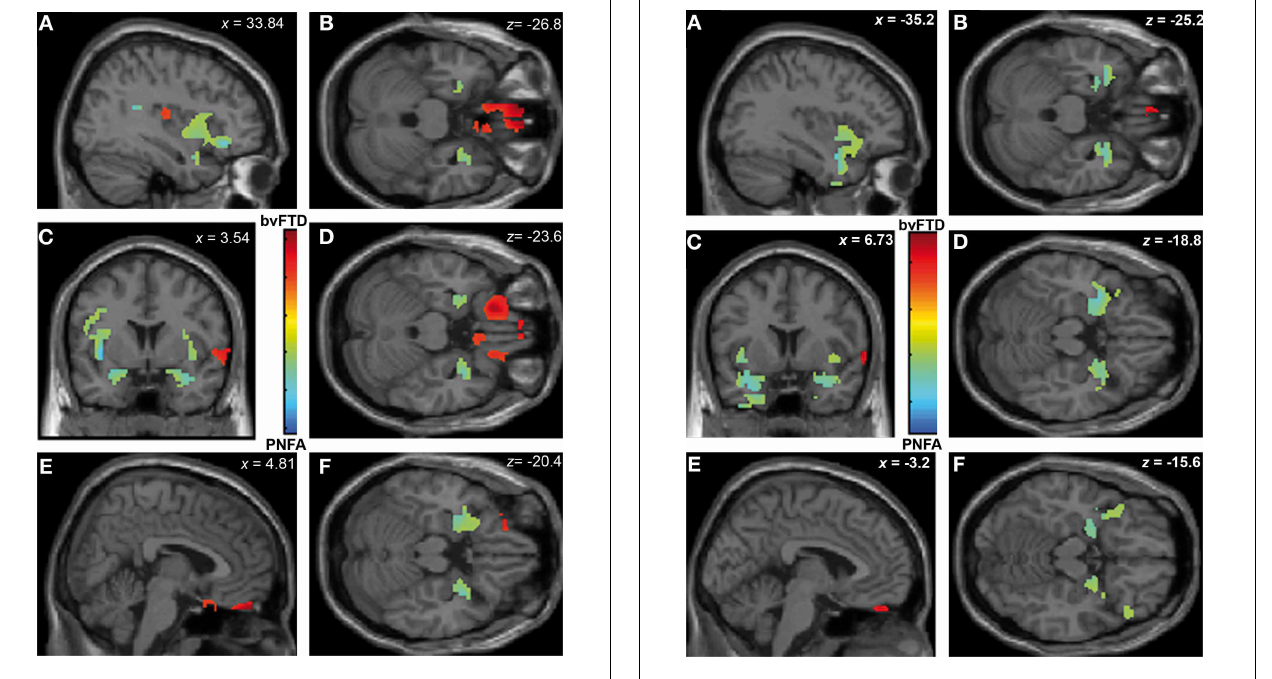
FIGURE 5 | Contrast vectors of bvFTD (red-yellow) and PNFA (light blue) atrophy that correlates with ToM. p < 0 . 05, small volume corrected. (A) Right insulo-temporal correlations for PNFA; (B,D,F) Temporal pole and amygdaline correlations for PNFA; (C) Bilateral insular correlations of PNFA; (E) Right gyrus rectus for bvFTD. PNFA, progressive non-fluid aphasia, bvFTD, behavioral variant